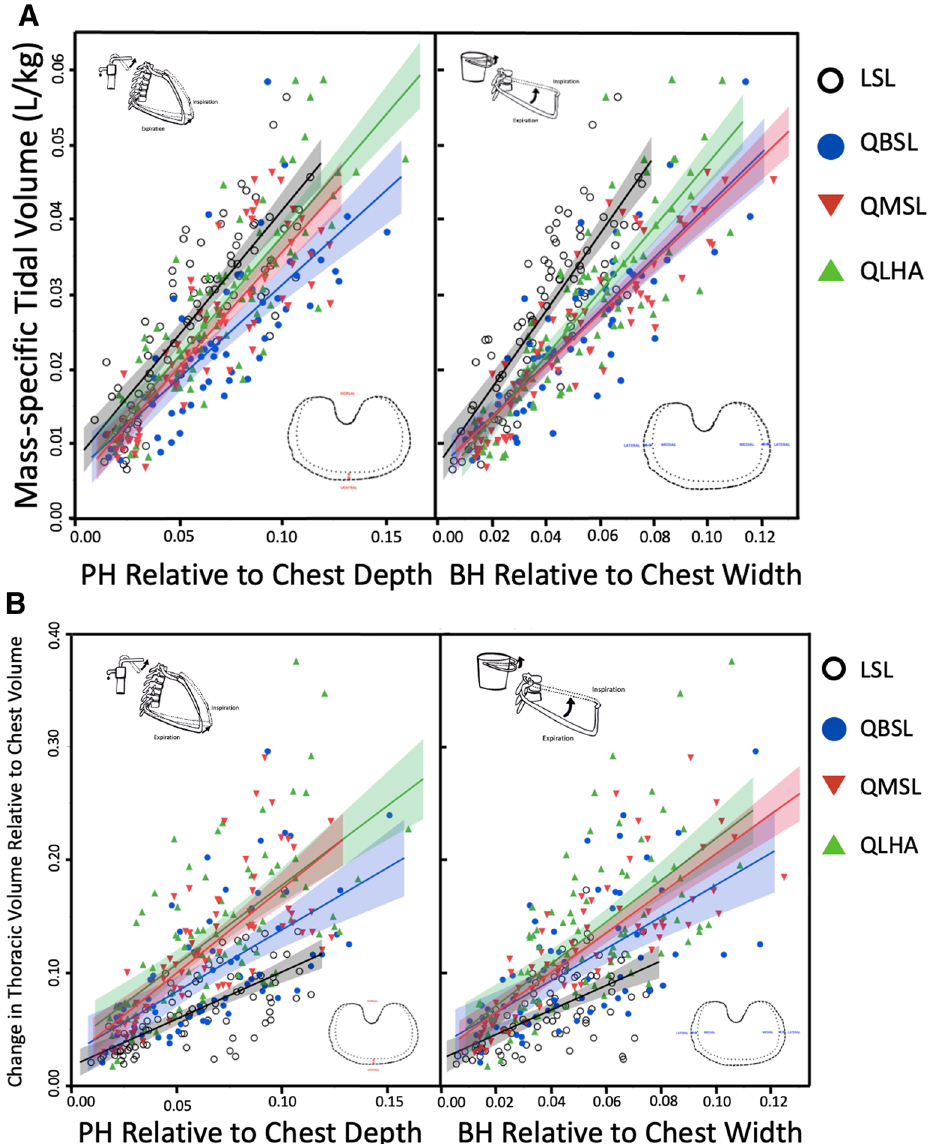
Figure 6. ( A ) Dorsoventral expansion normalized to chest depth (PH) drives increases in thoracic volume. Mass-specific V T (L/kg-BTPS) increases with both dorsoventral and mediolateral thoracic expansion in all populations. Mass-specific V T (L/kg-BTPS) increased with maximum dorsoventral expansion relative to chest depth more in LSL participants (slope ± S. 0.37 ± 0.02, R 2 = 0.70) than Quechua participants (p < 0.01). QLHA (0.35 ± 0.02, R 2 = 0.72; p = 0.006) and QMSL (0.32 ± 0.02, R 2 = 0.73; p = 0.091) increased more than QBSL (0.27 ± 0.02, R 2 = 0.60). Mass-specific V T (L/kg-BTPS) also increased with maximum mediolateral expansion relative to chest width significantly more in LSL participants (0.51 ± 0.03, R 2 = 0.71) than QLHA (p = 0.005), QMSL (p < 0.001) and QBSL (p < 0.001) participants. QLHA (0.42 ± 0.02, R 2 = 0.73) exhibited greater amounts of mediolateral expansion normalized to chest width (BH) relative to QMSL (0.35 ± 0.02, R 2 = 0.82; p = 0.020) and QBSL (0.36 ± 0.02, R 2 = 0.73; p = 0.081). QMSL and QBSL did not differ significantly (p = 0.739). Shading represents 95% CLs. ( B ) Change in thoracic volume relative to chest volume increased with maximum dorsoventral expansion relative to chest depth (PH) more in QLHA (p < 0.001), QMSL (p < 0.001) and QBSL (p = 0.101) participants than in LSL participants (slope ± S. 1.03 ± 0.07, R 2 = 0.47). QLHA (1.64 ± 0.12, R 2 = 0.44) and QMSL (1.62 ± 0.12, R 2 = 0.56) exhibited similar amounts of thoracic volume change relative to dorsoventral expansion (p = 0.927), while QBSL (1.27 ± 0.13, R 2 = 0.37) had less